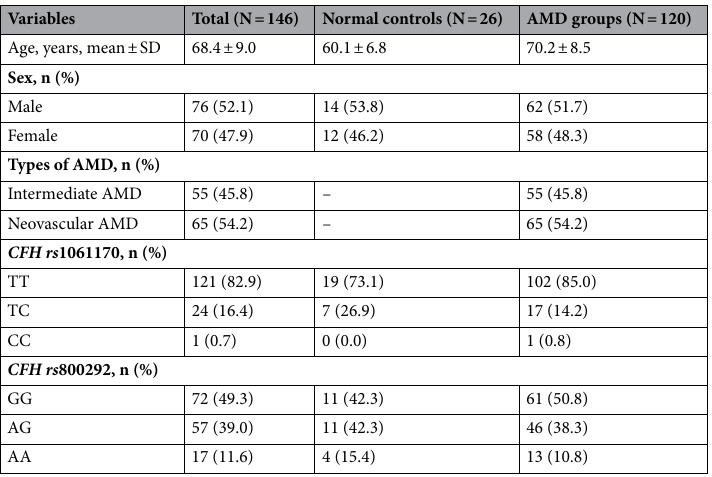
Table 2. The baseline demographics and distribution of genotype (complement factor H single nucleotide polymorphism of rs 1061170 and rs 800292) in controls and age-related macular degeneration groups. SD, standard deviation; AMD, age-related macular degeneration; CFH, complement factor H.